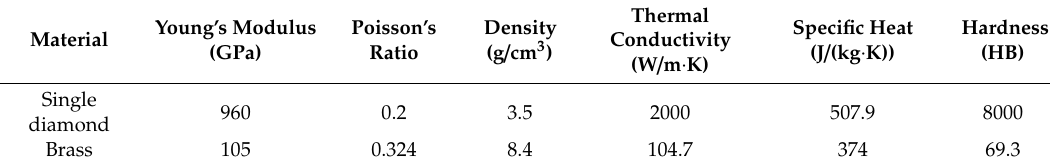
Table 2. Material characteristics of the tool and